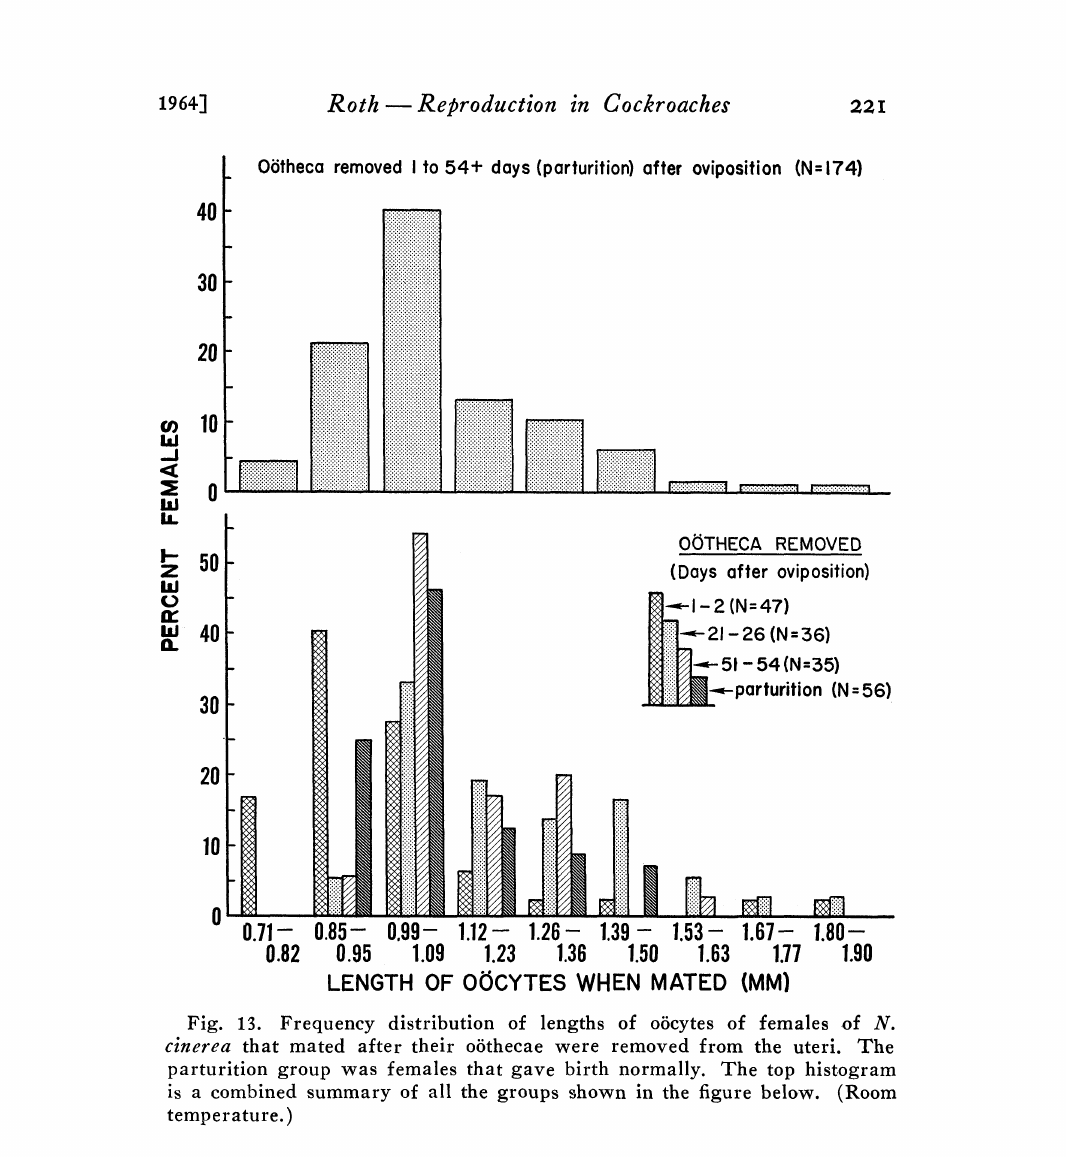
Fig. 13. Frequency distribution of lengths of oScytes of females ,of N. cinerea that mated after their o6thecae were removed from the uteri. The parturition group was females that gave birth normally. The top histogram is a combined summary of all the groups shown in the figure below. (Room